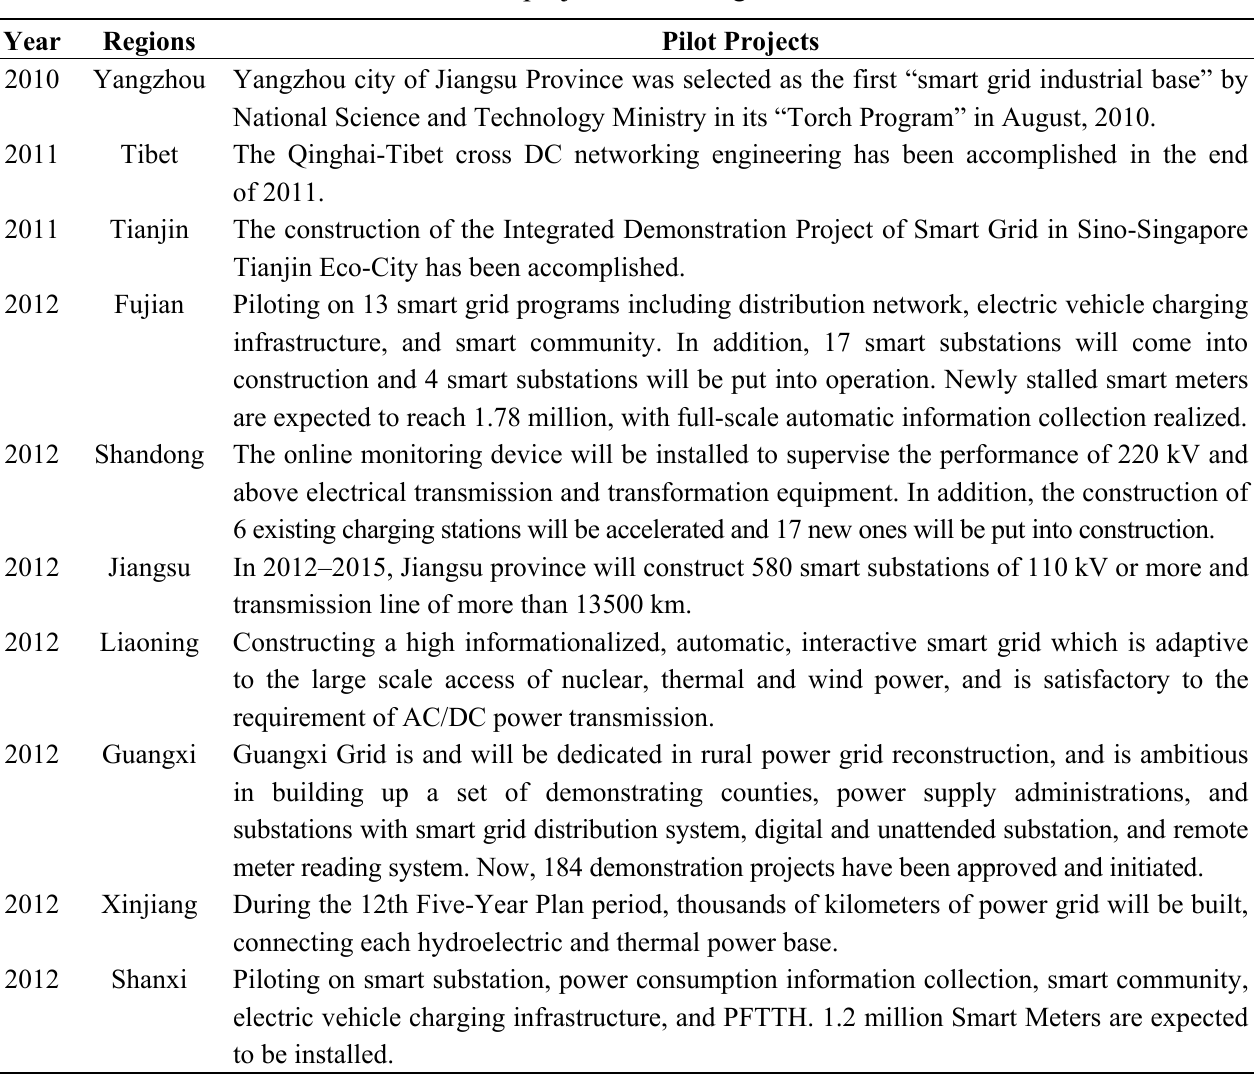
Table 2. Pilot projects of smart grid in